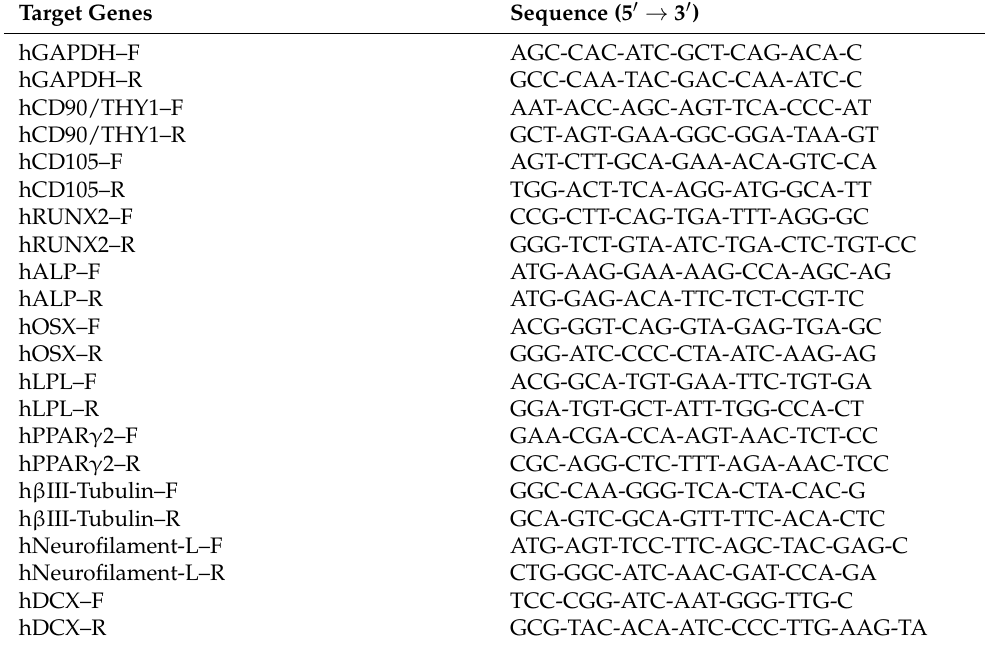
Table 1. Gene sequences used for qRT-PCR for the analysis of the osteogenic, adipogenic and neurogenic potential of human dental pulp stem